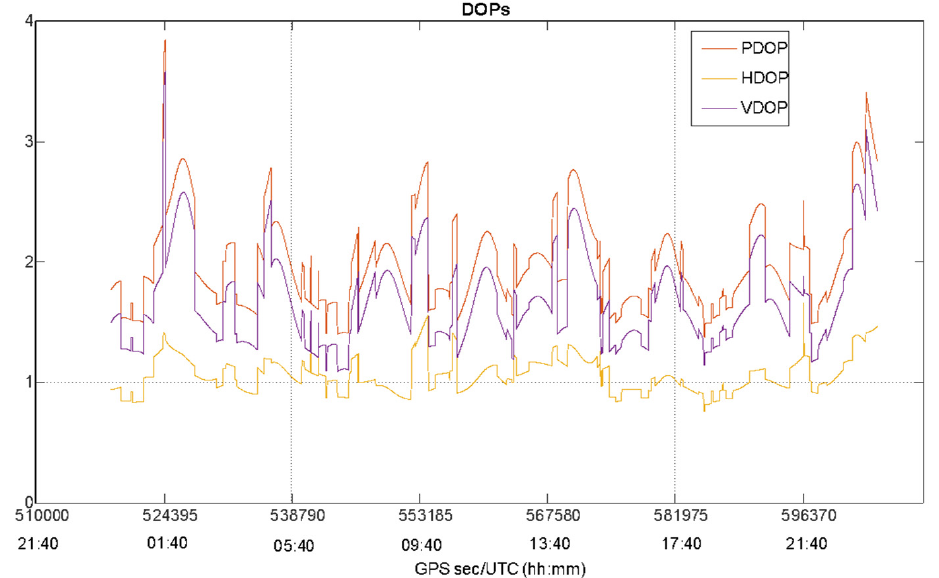
Figure 4. Position Dilution of Precision (PDOP), Vertical DOP (VDOP) and Horizontal DOP (HDOP)values as function of the time.